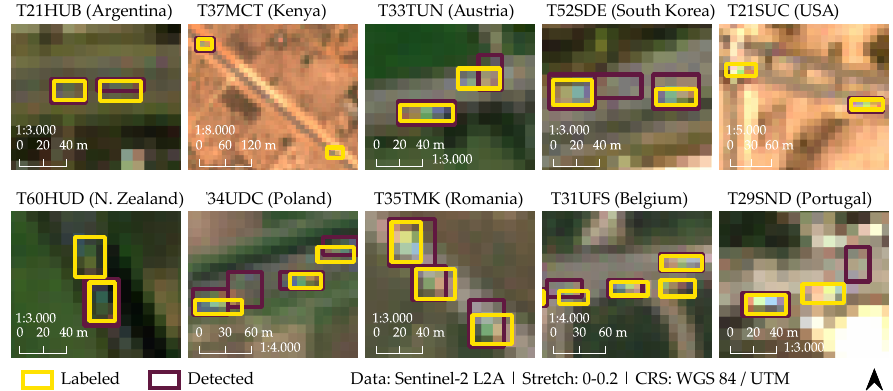
Figure 9. Box validation PR curves.